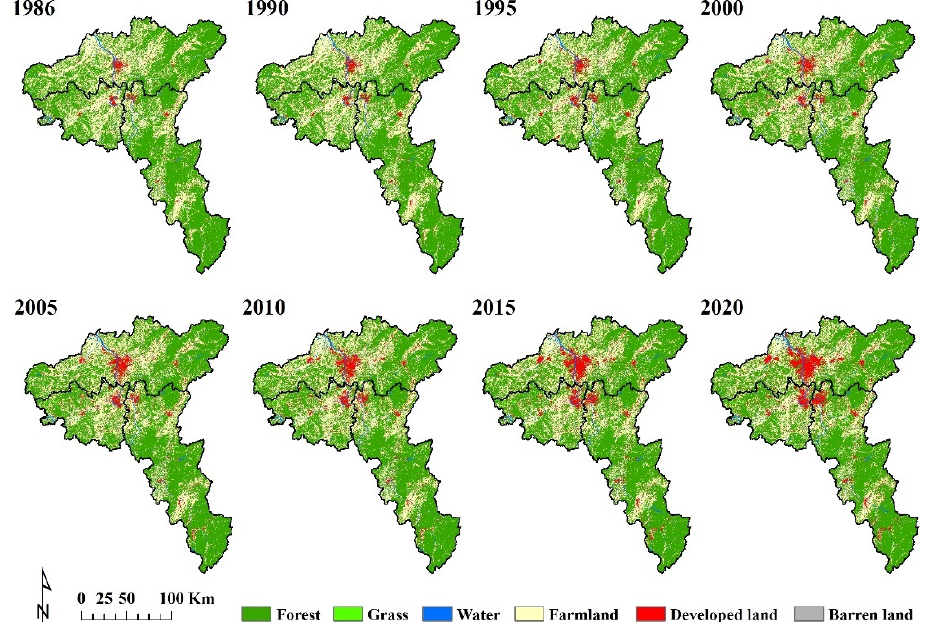
Figure 2. Land cover thematic maps of the Changsha—Zhuzhou–Xiangtan urban megaregion in 1986– 2020.